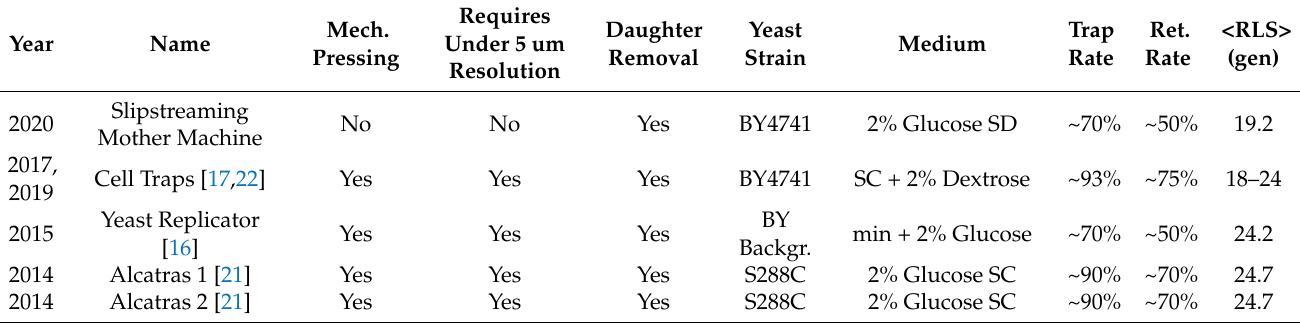
Table 1. Comparison of different Mother Machine